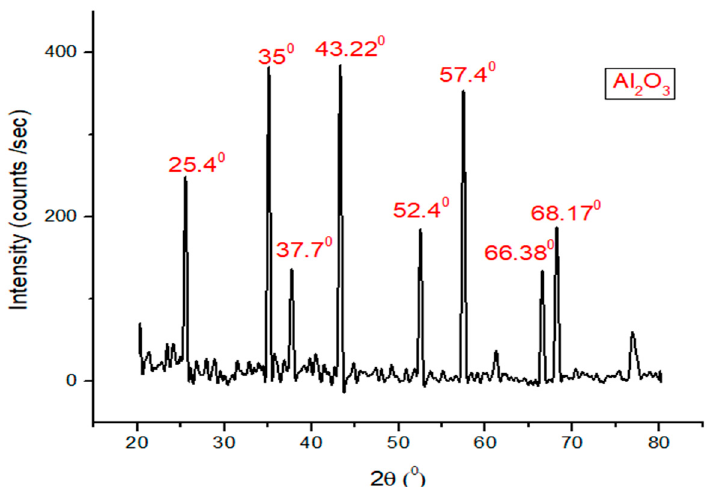
Figure 3. X-ray diffraction analysis of alumina nanoparticles. Figure 3. X-ray di ff raction analysis of alumina